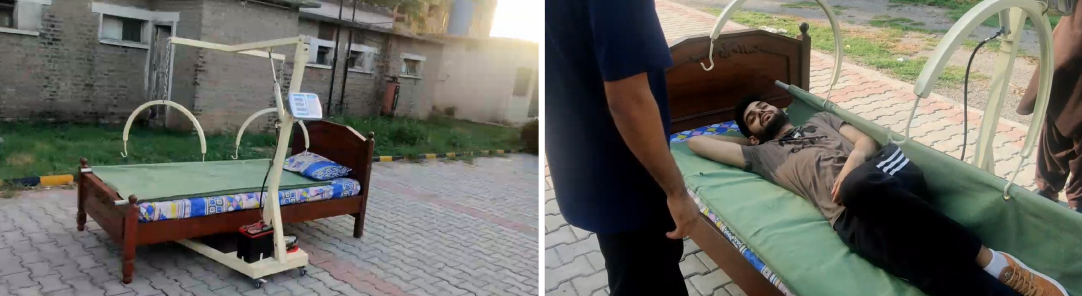
Figure 14. Setting up the device for lateral turning.